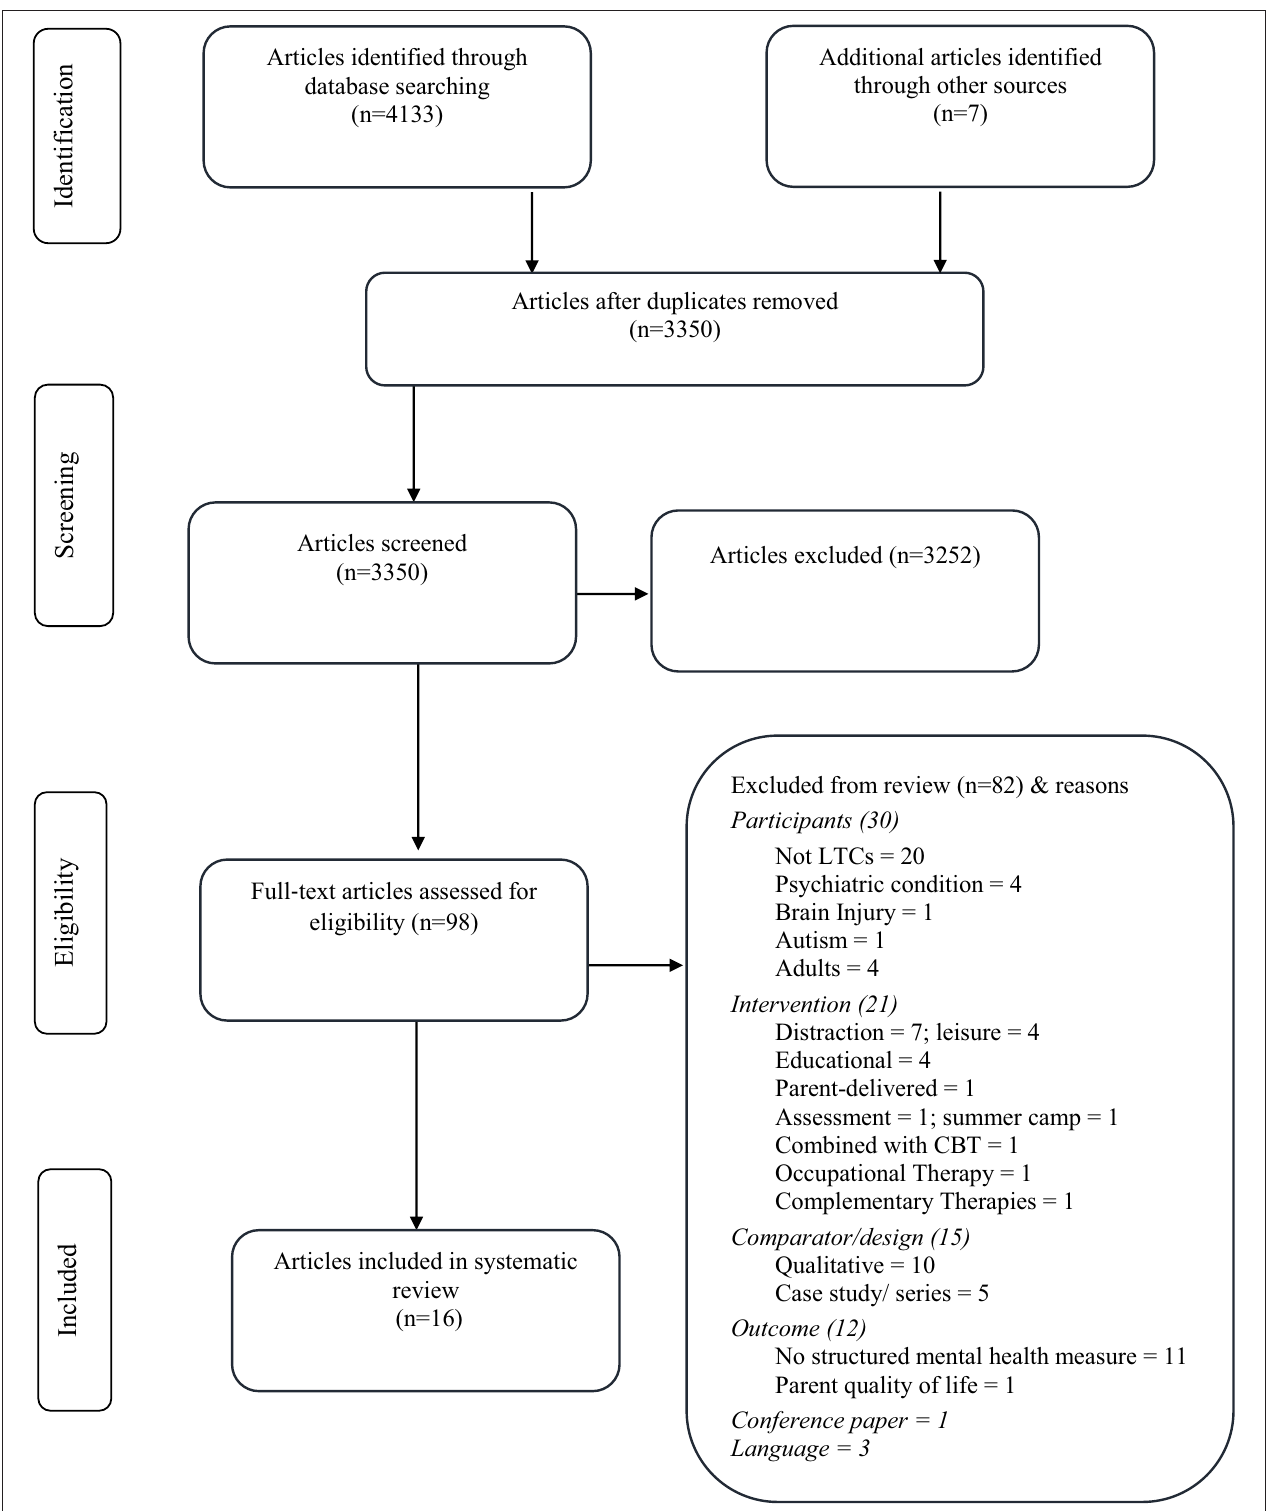
FIGURE 1 | The PRISMA flowchart showing study selection process.